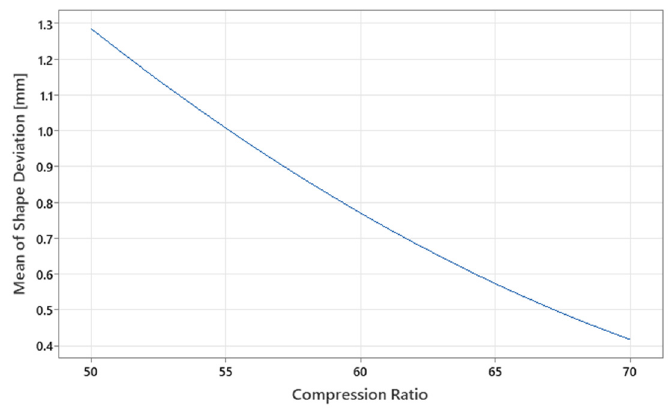
Figure 7. Effect of the compression ratio (%) on the mean of the shape deviation (mm) .